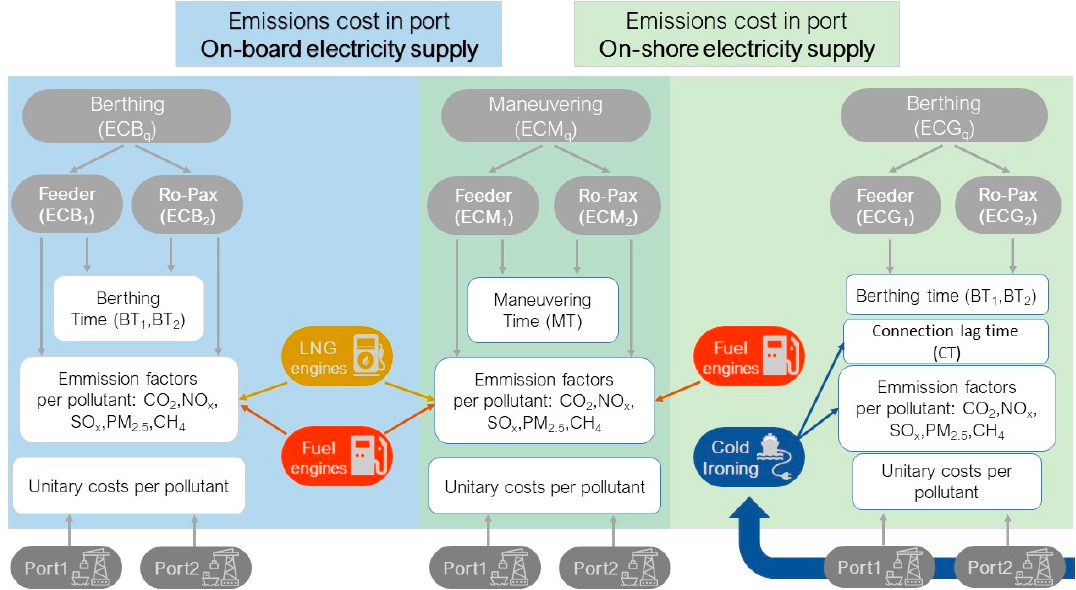
Figure 1. Dependences of the variables involved in the calculation model for port emissions